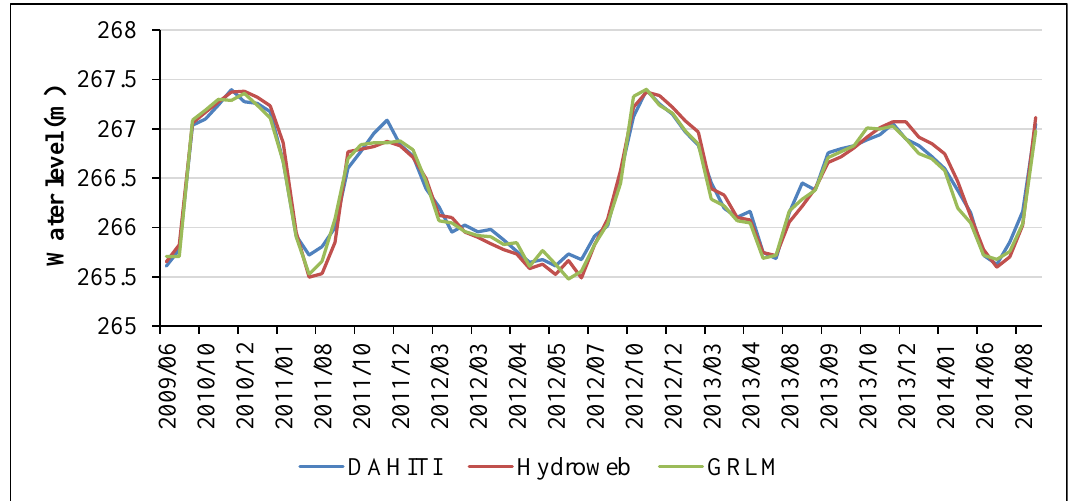
Figure 8. Time series of water level on days when the observations of all three altimetry products are available.